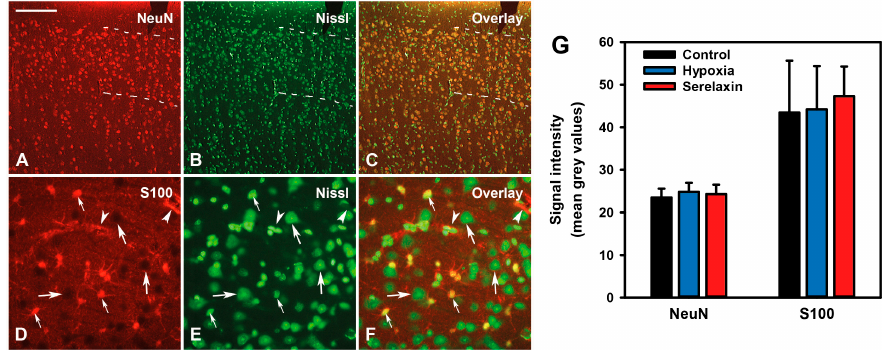
Figure 8. Immunohistochemical labeling of cortical neurons and astrocytes. Transverse cortical sections from a control animal (hypoxia only) stained for the pan-neuronal marker NeuN ( A ) and the astrocyte antigen S100 ( D ). ( B , E ) Nissl-like counterstaining and ( C , F ) overlays of the respective sections. ( A – C ) NeuN expression in neuronal cell bodies; dashed lines delineate cortical layers II and III. ( D – F ) S100 labelling of astrocyte cell bodies (thin arrows), astrocyte feet around blood vessels (arrowheads), and astrocyte processes throughout the neurophil. Neuronal cell bodies are S100-negative (thick arrows). Scale bar = 400 µm for A–C, 100 µm for D–F. ( G ) Immunostaining in cortical layers II and III of animals not undergoing the experimental procedure (control) or subjected to hypoxia alone (hypoxia) or hypoxia plus serelaxin treatment (Serelaxin). Mean ± SD; N = 5 per group. No differences were found between the groups (ANOVA; NeuN: F 2,12 = 0.45, p = 0.65; S100B: F 2,12 = 0.21, p = 0.82).